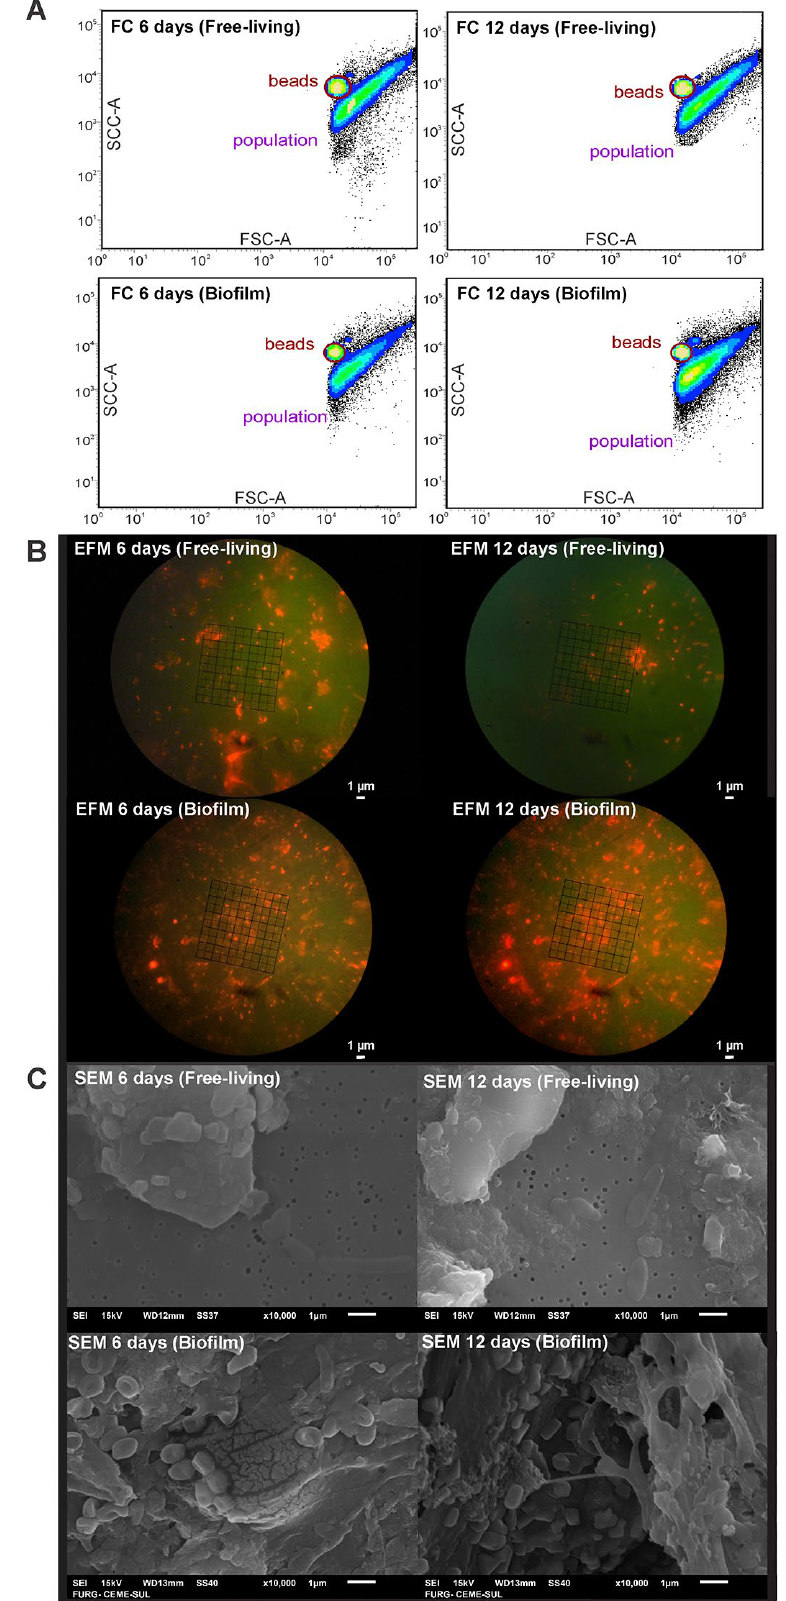
Fig. S4. – Marine free-living and biofilm prokaryote populations at 6 and 12 days of exposure estimated by different methodologies: using a flow cytometer (FC) (BD FacsVerse TM ), where lighter colours are related to higher density cells, forward light scatter for size estimates (FSC-A), light side scatter for complexity estimates (SSC-A). A, using an epifluorescence microscope (EFM) stained with acridine orange; B, using a scanning electronic microscope (SEM)